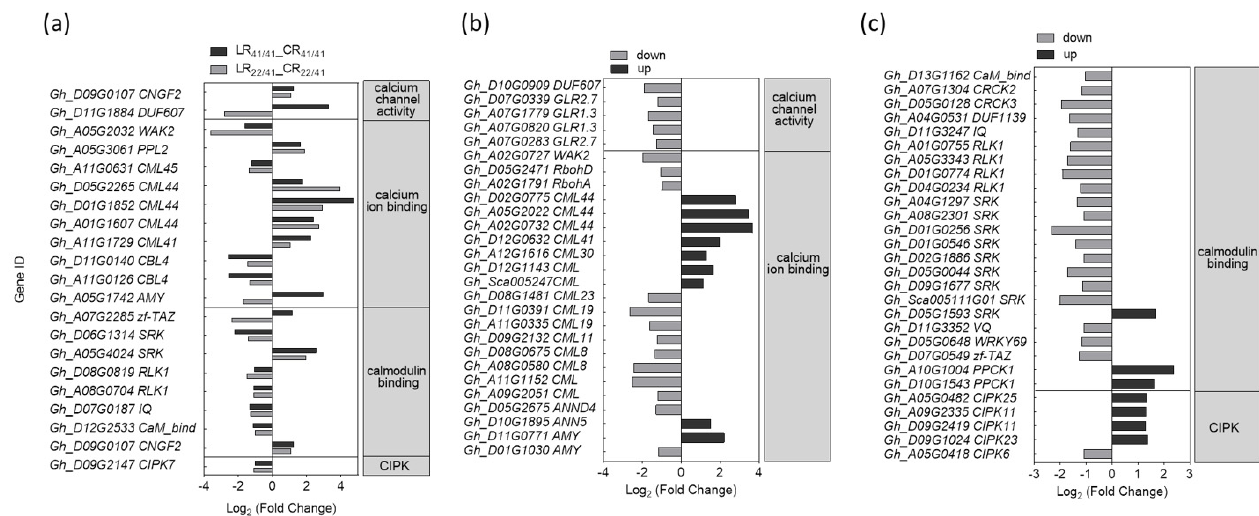
Figure 3. The differentially expressed genes (DEGs) involved in Ca 2+ (calcium) signaling in R common ( a ) and R 22/41 unique ( b , c ) group. R common: Common DEGs in roots of CCRI41/CCRI41 (scion/rootstock) and SCRC22/CCRI41 under potassium (K + ) deficiency. R22/41 unique: DEGs specifically identified in roots of SCRC22/CCRI41. Three DEGs, including one annotated by Ca 2+ channel activity ( Gh_D11G1884 ), one related to Ca 2+ binding ( Gh_A05G1742 ) and one associated with CaM binding ( Gh_A07G2285 ) were up-regulated in the roots of CCRI41/CCRI41 but down-regulated in